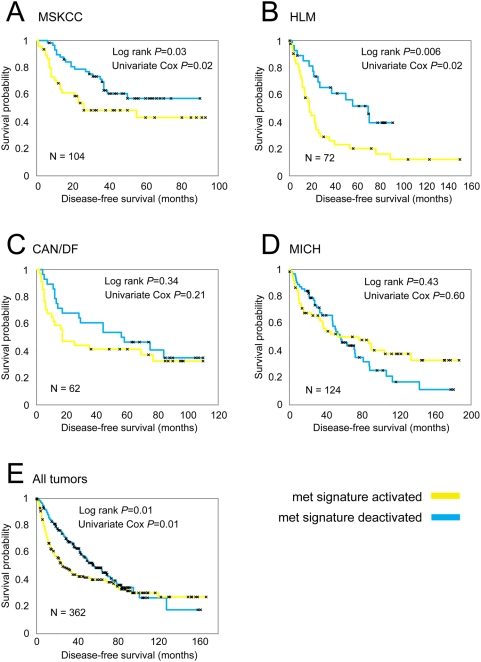
The spontaneous mouse metastasis signature is associated with poor prognosis in human lung tumor profile datasets from the Director's Challenge Consortium.Kaplan-Meier analysis comparing the differences in risk between human lung tumors showing activation (yellow line, t-score>0) and tumors showing deactivation (blue line, t-score<0) of the mouse model metastasis signature. Datasets from the study by Shedden et al. [15] and represent four independent cohorts from (A) Memorial Sloan-Kettering Cancer Center (MSK), (B) Moffitt Cancer Center (HLM), (C) Dana-Farber Cancer Institute (CAN/DF), and (D) University of Michigan Cancer Center (MICH). (E) Kaplan-Meier analysis of tumors combined from all four datasets (N = 362).